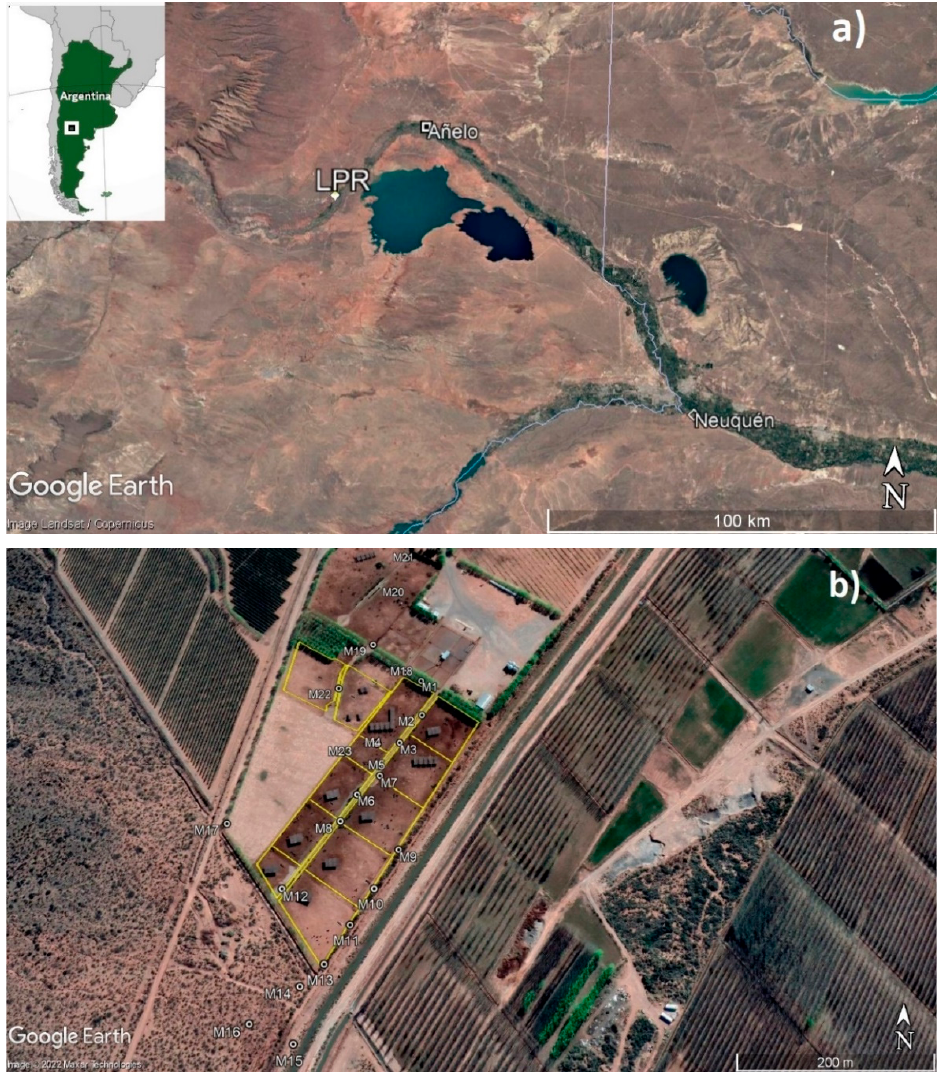
Figure 1. ( a ) Location of La Paisana ranch (LPR) in Neuquén. ( b ) Enlarged satellite image of the pens at LPR (yellow lines) and location of the sampling points (Mi) described in Table 1.